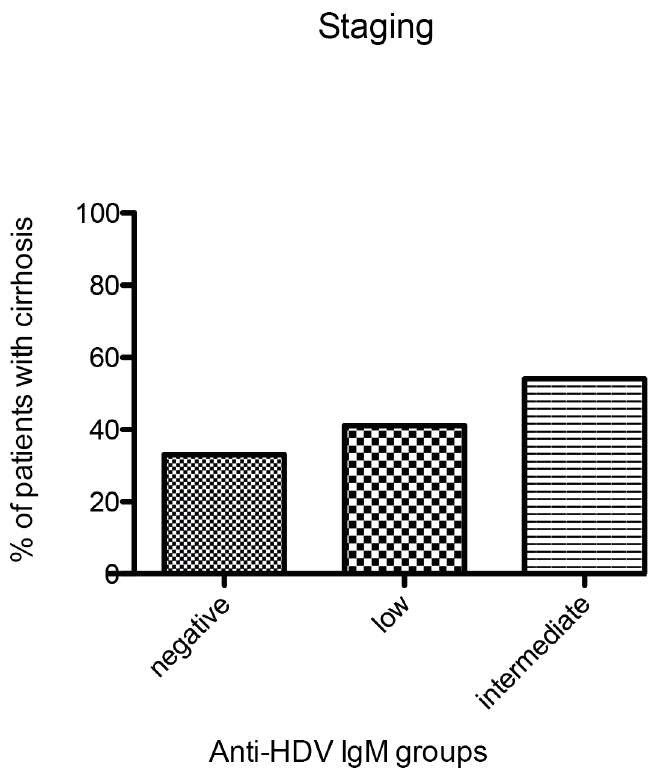
Figure 5. Histological staging of the HIDIT-2 cohort. Diagrammed% of patients with cirrhosis (based on the classification indicated in material and methods) within the anti-HDV IgM groups.